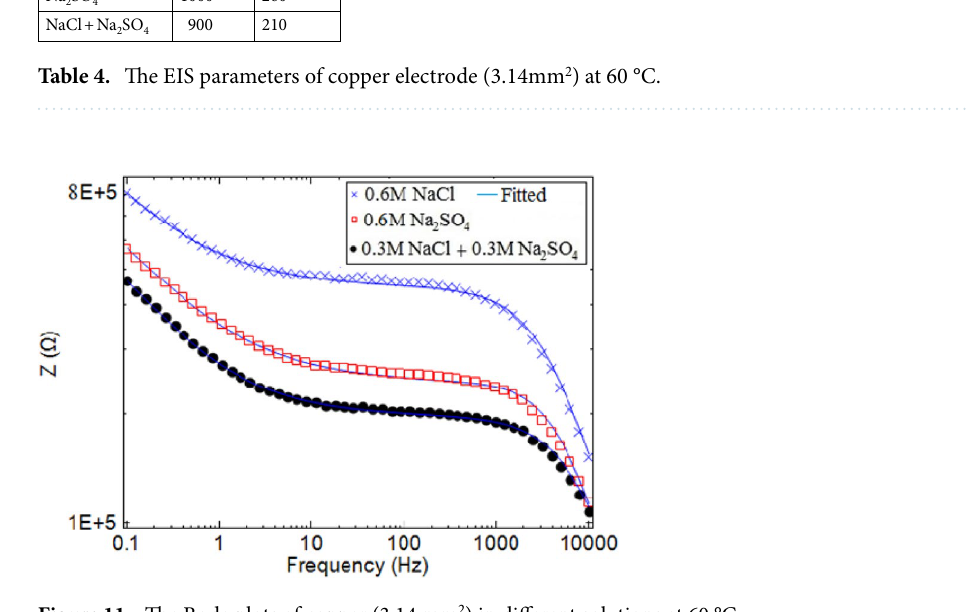
Figure 11. The Bode plots of copper (3.14 mm 2 ) in different solutions at 60